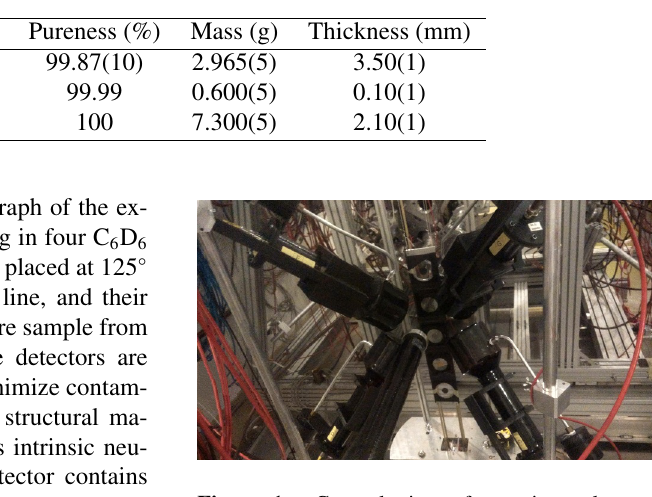
Figure 1. General view of experimental setup mounted in EAR1 for the measurement of the 80 Se(n, γ ) cross